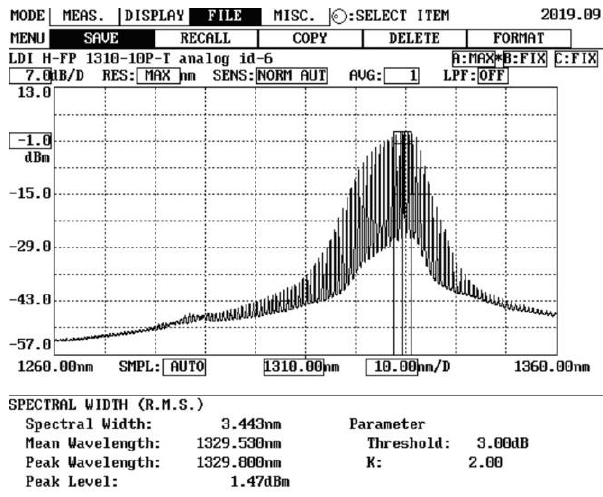
Figure 12. Optical spectrum of DMD analyzer Fabry–Perot LD.